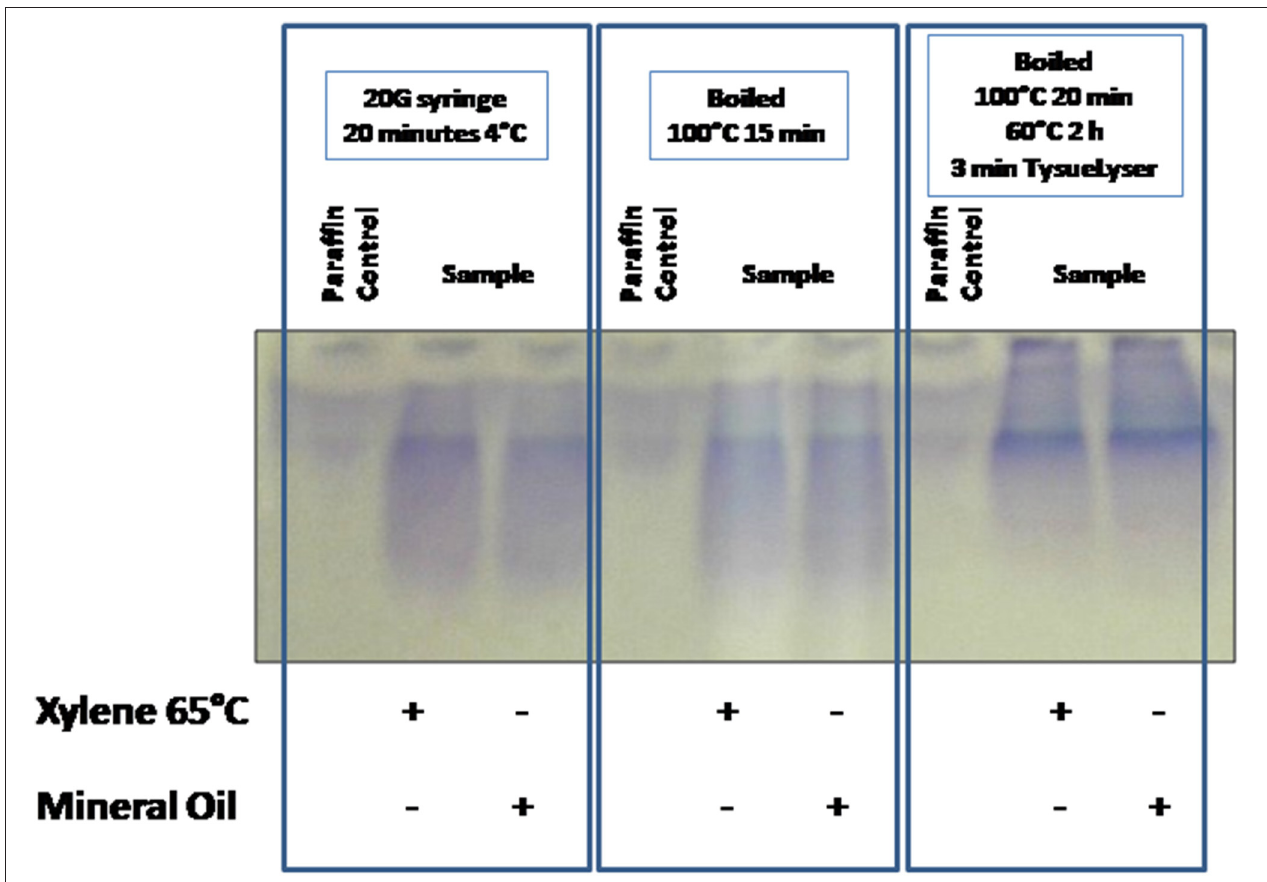
FIGURE 2 | Comparison of the tissue disaggregation methods (protocols 1–3). 1D SDS-PAGE 10% gels were performed to evaluate the protein integrity. Deparaffinization with xylene at 65 ◦ C or with mineral oil at 95 ◦ C, and protein extraction buffer 6 (RIPA LB) were selected.